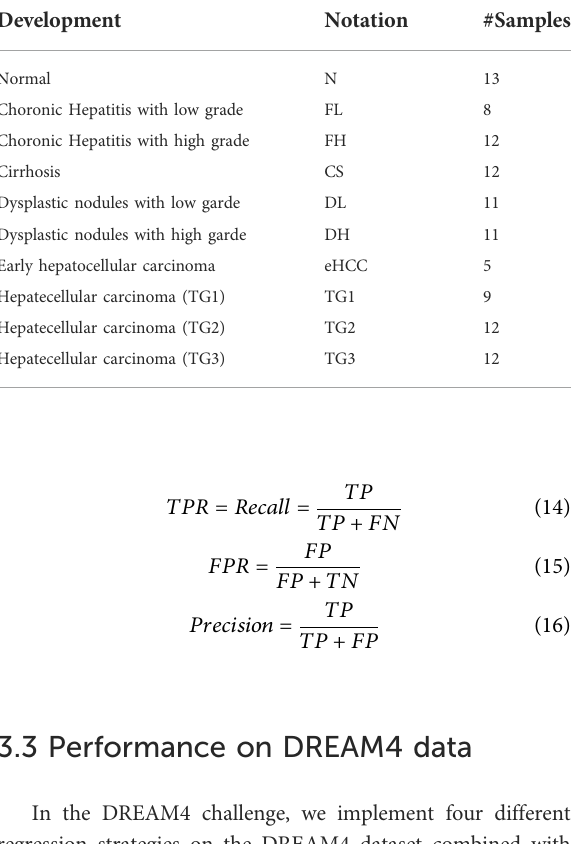
TABLE 2 The development stages of